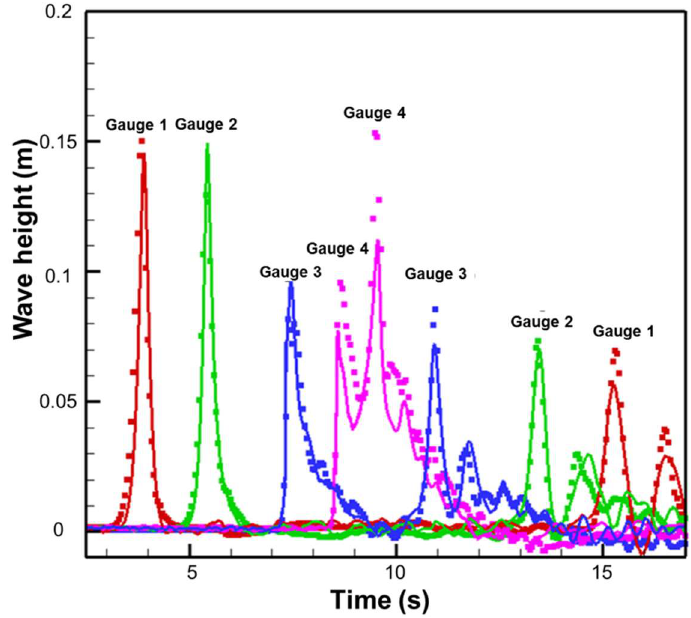
Figure 17. Time history of wave height for case 2 with particle sizes of 0.005 m (solid lines: numerical simulated results, symbols: hydraulic experiments).